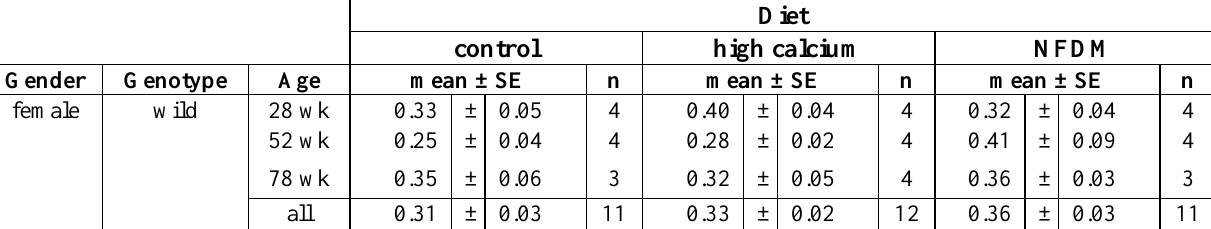
Table 3. Percentage of total muscle mass calculated from gastrocnemius and soleus muscle per body weight in aP2-agouti transgenic and wild-type mice fed control, high calcium or NFDM diets at 28, 52 and 78 weeks of age. Values are expressed as mean ± SE. Non- matching superscripts denote significant differences between diet groups, p < 0.05. Diet control high calcium NFDM Gender